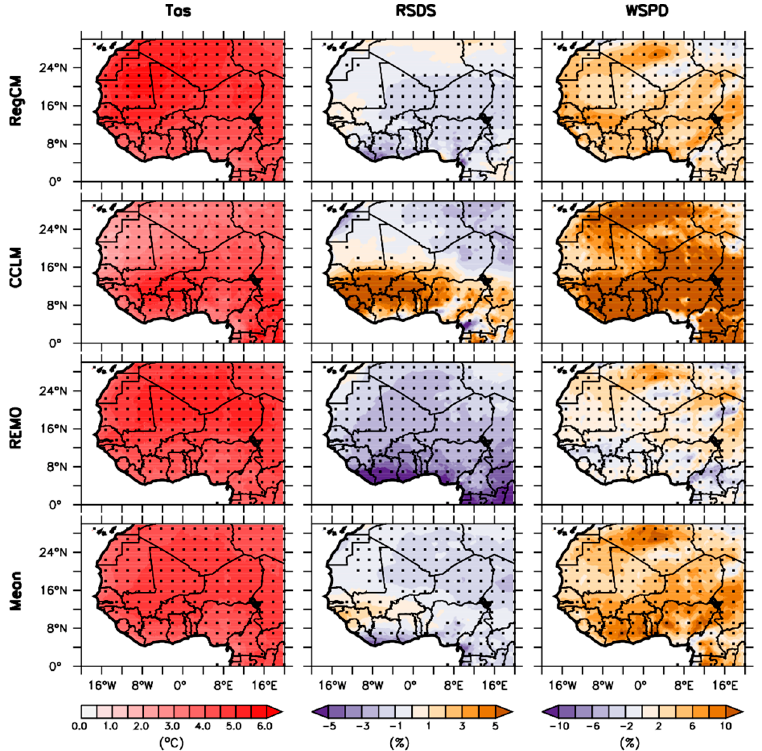
Figure 9. Same as Figure 8 but for the far future (2071–2100) and under the RCP8.5